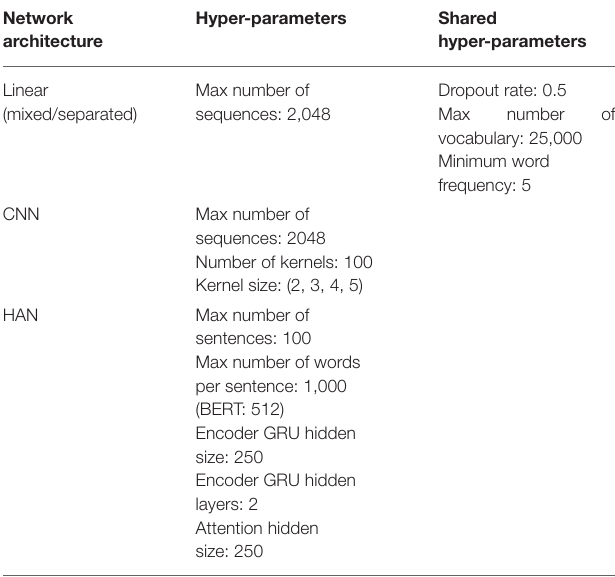
TABLE 3 | Hyper-parameters used for the three